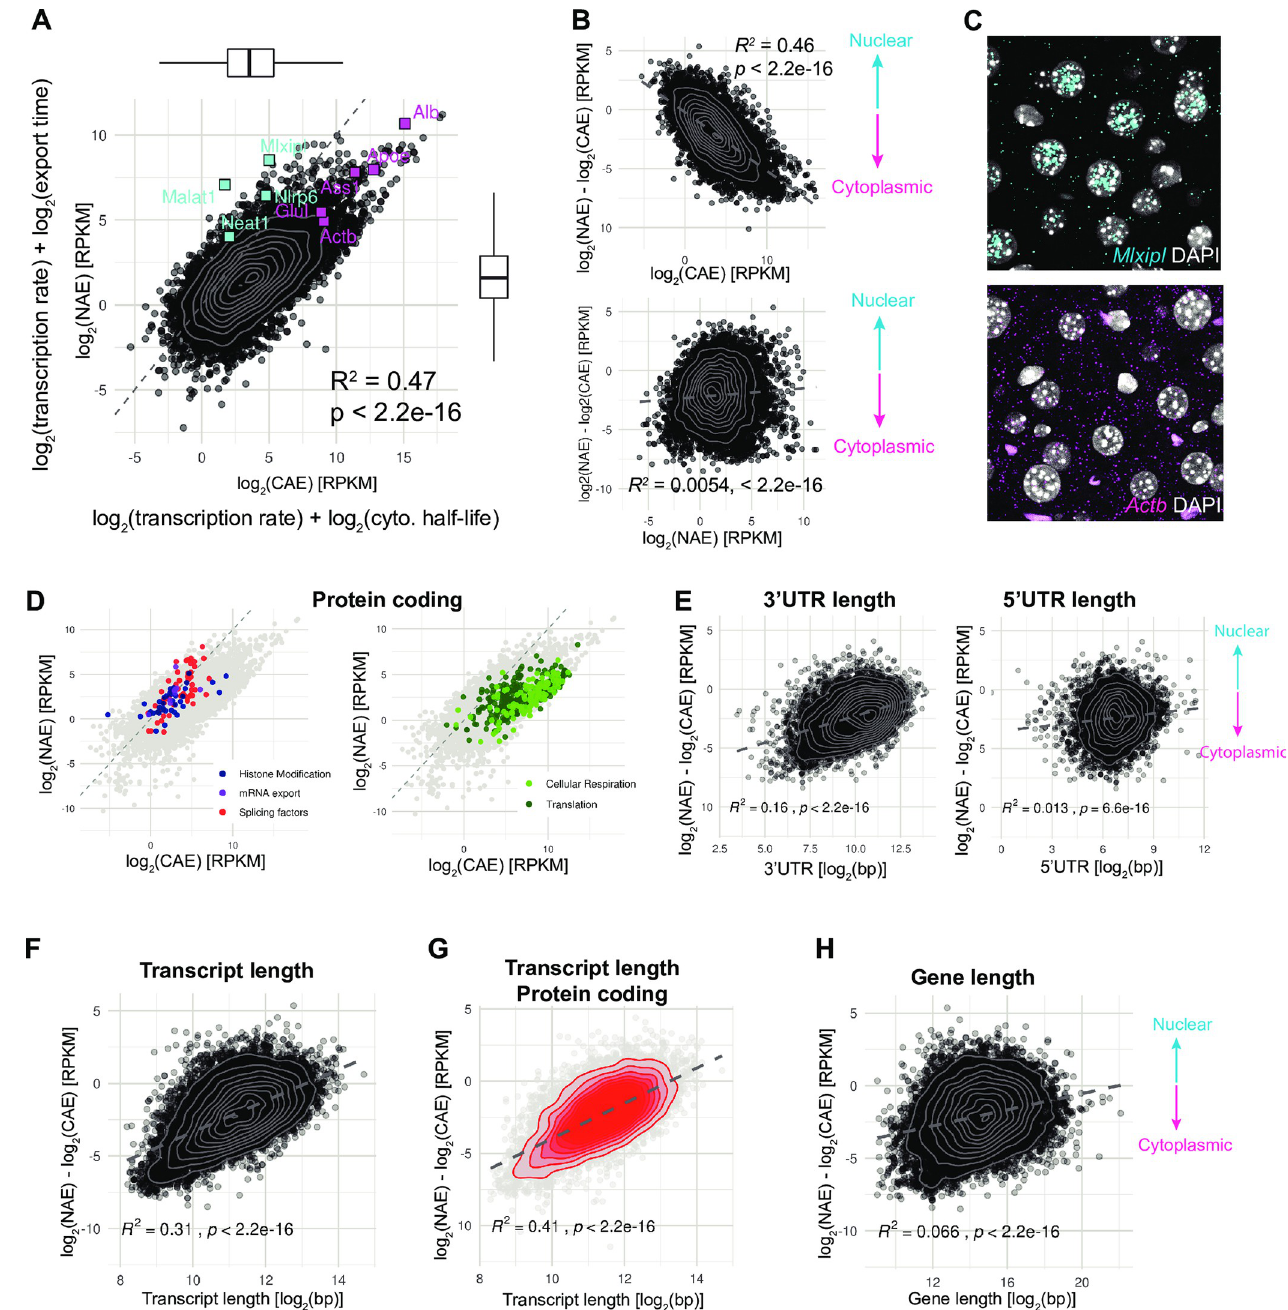
Fig 2. The ratio of nuclear and cytoplasmic mRNA abundance is related to transcript length. A: Expression level of nuclear mRNA (NAE) versus cytoplasmic mRNA (CAE) in log 2 (RPKM), averaged over 6 time-points and 12 animals. In our model, the level of NAE corresponds to the transcription rate plus the nuclear half-life, and the level of CAE to the transcription rate plus cytoplasmic half-life (all in log 2 -scale). Cyan squares represent known nuclear genes and magenta squares cytoplasmic genes [4]. Dashed line indicates the 1:1 ratio. Note here that the diagonal line has been scaled with the dataset (see Methods). Grey contour lines: 2D kernel density estimation. Number of genes = 10914. B : Log 2 -ratio of NAE / CAE against the average expression in the cytoplasm in log 2 -scale (up) or in the nucleus (bottom). C : smFISH of the Mlxipl and Actb transcripts in liver FFPE sections, at ZT12. Nuclei are stained with DAPI (grey). D : GO Terms enrichment analysis of nuclear and cytoplasmic protein coding genes. Left: All the genes belonging to the nuclear enriched GO Terms are highlighted in color: histone modifications (GO:0016570, GO:0033169, GO:0070076, GO:0006306, and GO:0044728), mRNA export (GO:0010793, GO:0010793), and splicing (GO:0006376, GO:0043484). Right: all the genes belonging to some of the cytoplasmic enriched GO Terms are highlighted in color: Cellular respiration (GO:0042775, GO:0022904, GO:0015986, GO:0006123), and Translation (GO:0006412, GO:0002181, GO:0006414,). E, F, G, H : log 2 (NAE/ CAE) ratio against the following genomic features: 5’UTR length and 3’UTR length (E), transcript length (spliced isoform, F, G) and gene length (exon